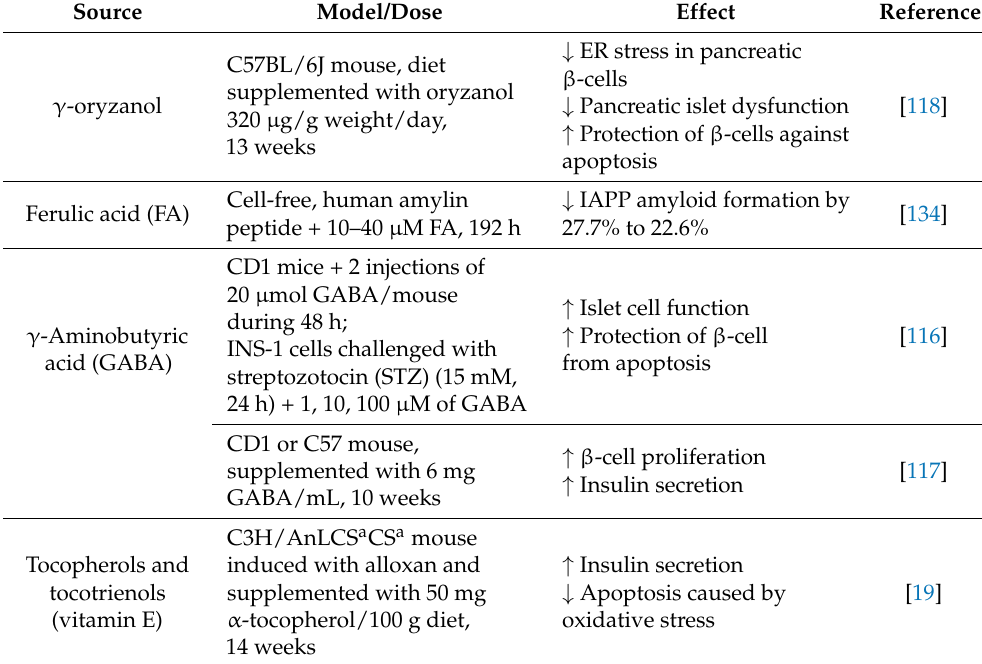
Table 7. Effect of bioactive rice compounds against pathological mechanisms associated with